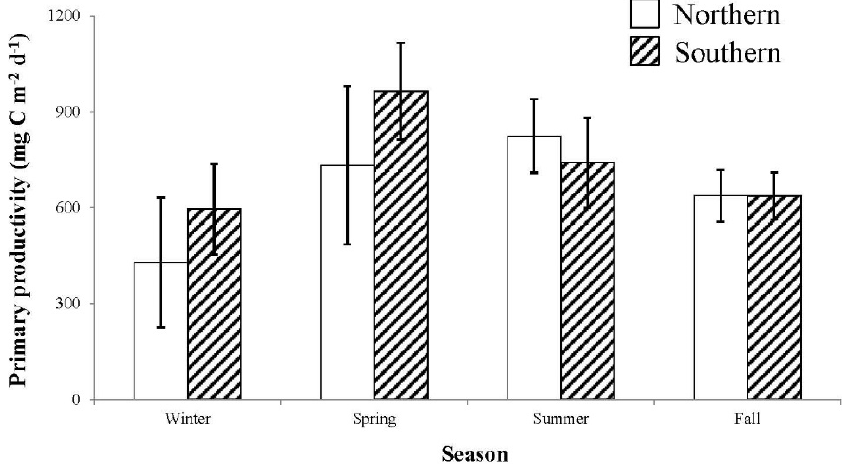
Figure 6. Climatological seasonal patterns of primary productivity for the southern and northern areas in the East Sea. Dashed and solid boxes represent annual averaged primary productivity values in the southern and northern areas, respectively. The error bars stand for standard deviation.